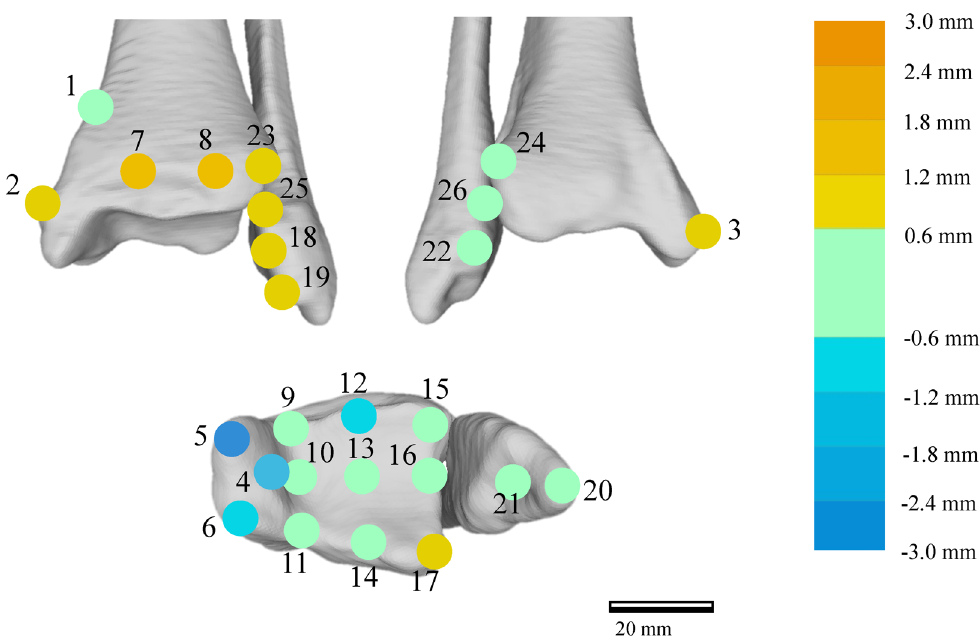
Figure 5. The color map of the mean surface deviation in the OA group at the 26 regions of interest (See Table 1).